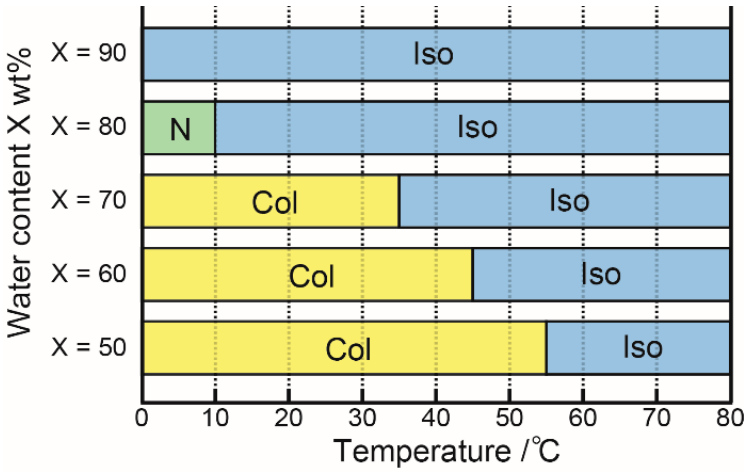
Figure 3. Bar graph of the thermotropic phase transition behavior of the mixtures of pQpdS-Ch and H 2 O in the 100–X:X weight ratios on cooling.